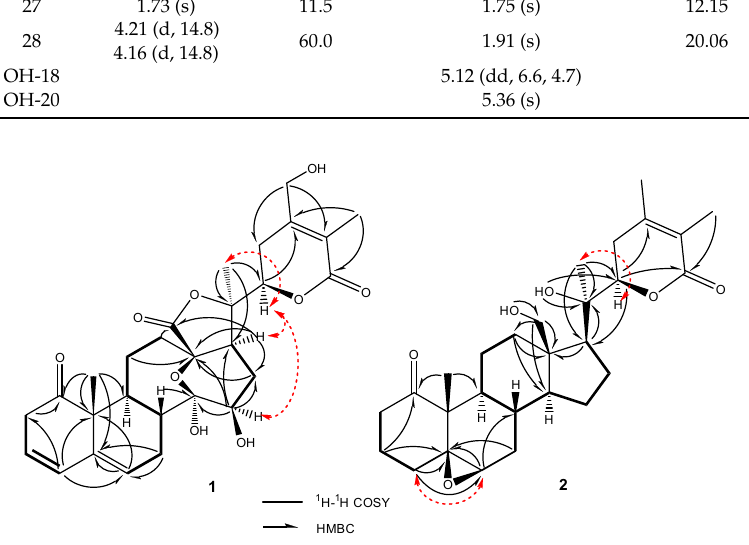
Figure 2. Key HMBC, NOE and 1 H- 1 H COSY correlations of 1 and 2.